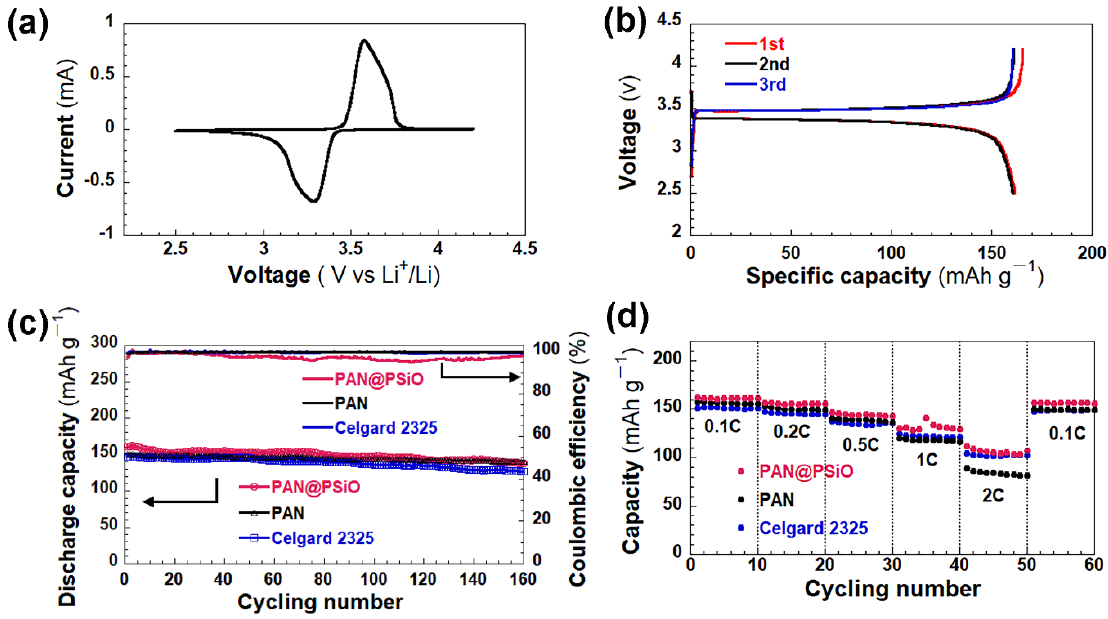
Figure 5. ( a ) CV curves of the LiFePO 4 |PAN@PSiO|Li battery between 4.2 and 2.5 V at a scan rate of 0.1 mV s − 1 ; ( b ) potential–capacity profiles of the LiFePO 4 |PAN@PSiO|Li battery at 1st, 2nd, and 3rd cycles under 0.1 C at room temperature; ( c ) cycling performance of the LiFePO 4 |Celgard 2325|Li, LiFePO 4 |PAN|Li and LiFePO 4 |PAN@PSiO|Li batteries at 0.2 C; ( d ) rate performance of LiFePO 4 |Celgard|Li, LiFePO 4 |PAN|Li, and LiFePO 4 |PAN@PSiO|Li batteries at current densities varied from 0.1 C to 2 C.